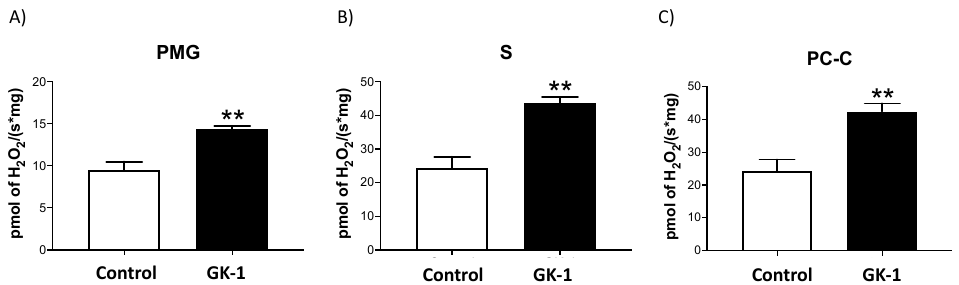
Figure 3. GK-1 induces hydrogen peroxide (H 2 O 2 ) production in triple-negative breast tumors. ( A ) H 2 O 2 production during the stimulation of oxidative phosphorylation (OXPHOS) through complex I (CI) with pyruvate–malate–glutamate (PMG). ( B ) H 2 O 2 production during the stimulation of OXPHOS through complex II (CII) with sodium succinate. ( C ) H 2 O 2 production during β -oxidation stimulation with palmitoyl-carnitine-CoA (PC-C). t -Student test, control vs. GK-1, ** p < 0.005. Results are expressed as mean ± SEM, n = 5.